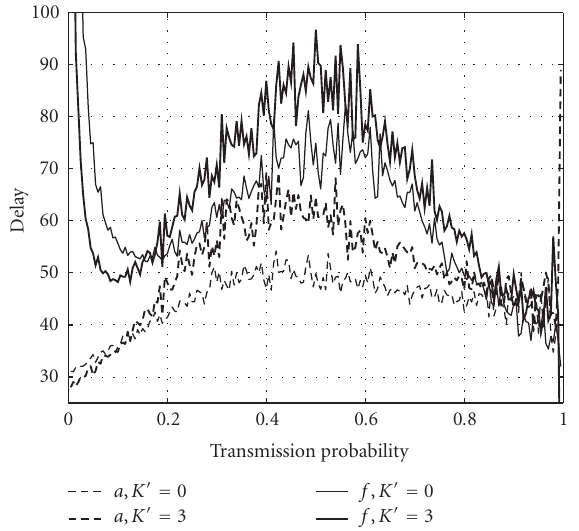
Figure 22: Stability region y i of the dynamic ( K (cid:5) = 3) and static ( K (cid:5) = 0) cases for K = 4 with a reset of the K value of node 7 (asymmetric network of Figure 11).